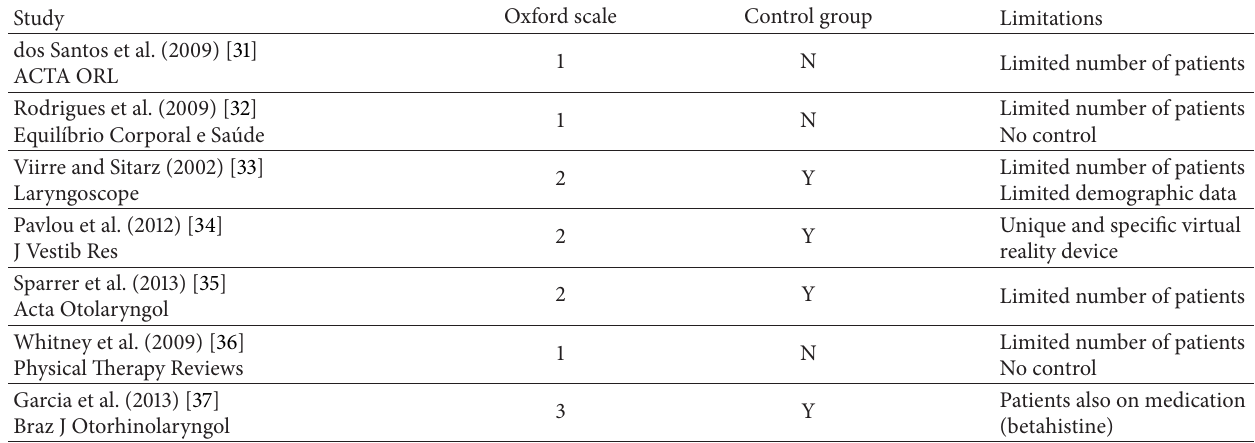
Table 3: Studies reliability assessed according to the Oxford grading